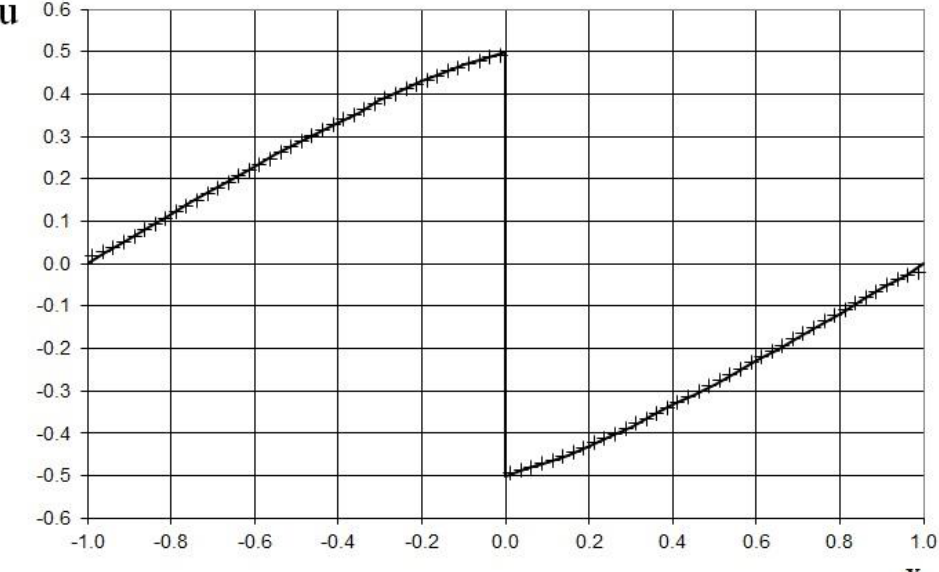
Figure 4. Velocity plot for the problem (45) for the inviscid Burgers’ equation (t = 1.1): the exact solution [40] (line), and the present method (cross).